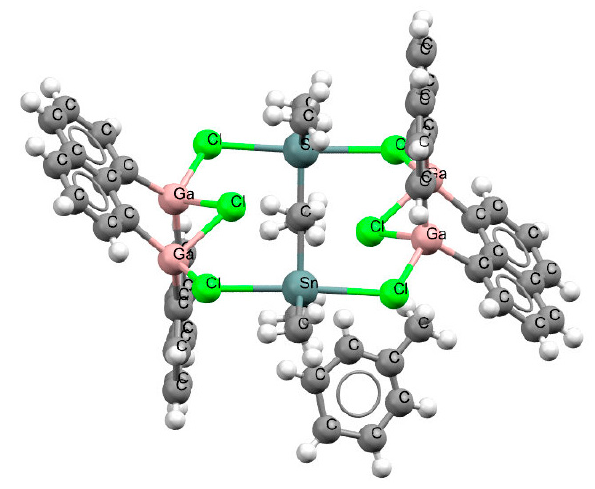
Figure 6. The fragment of the crystal structure of tetrakis( µ 2 -1,8-naphthalenediyl)–hexakis ( µ 2 -chloro)-hexamethyl-tetragallium (iii)-di-tin toluene solvate (refcode YIRHIQ).